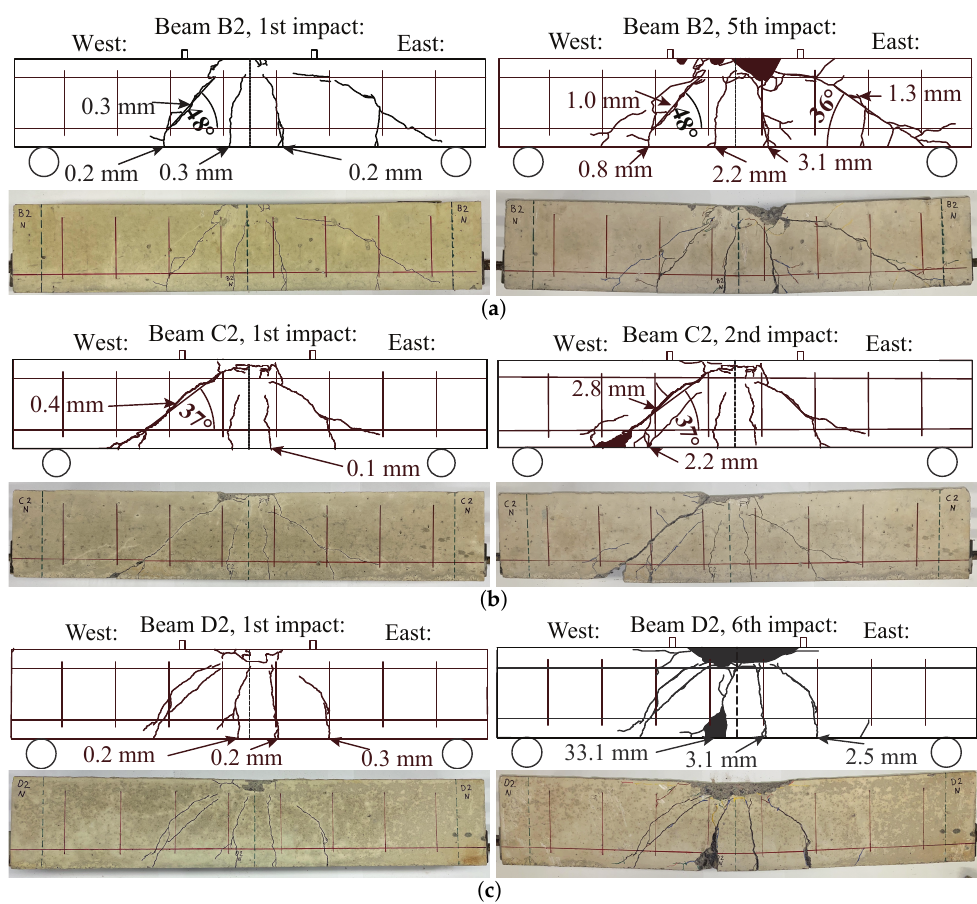
Figure 9. ( a ) Damage to B2 during sequential impact tests; ( b ) damage to C2; and ( c ) damage to D2. Beam D2 in Figure 9c showed to withstand six impacts before local failure